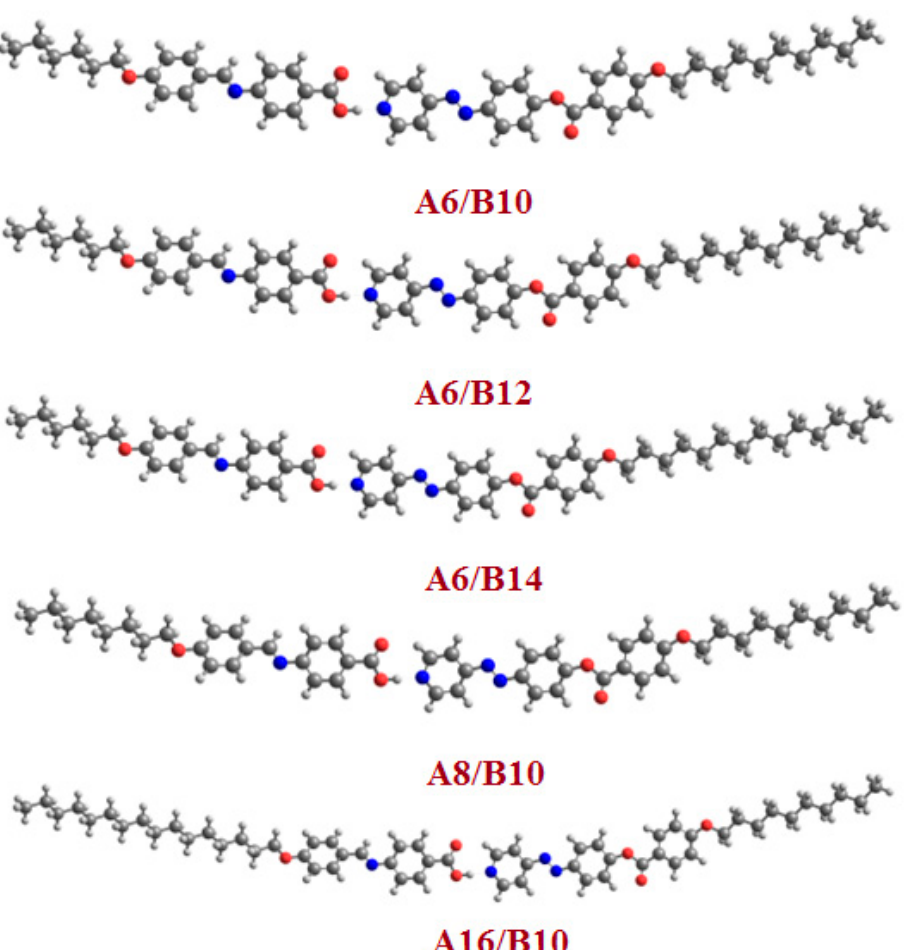
Figure 5. Calculated molecular geometrical structure of SMHBCs An / Bm.